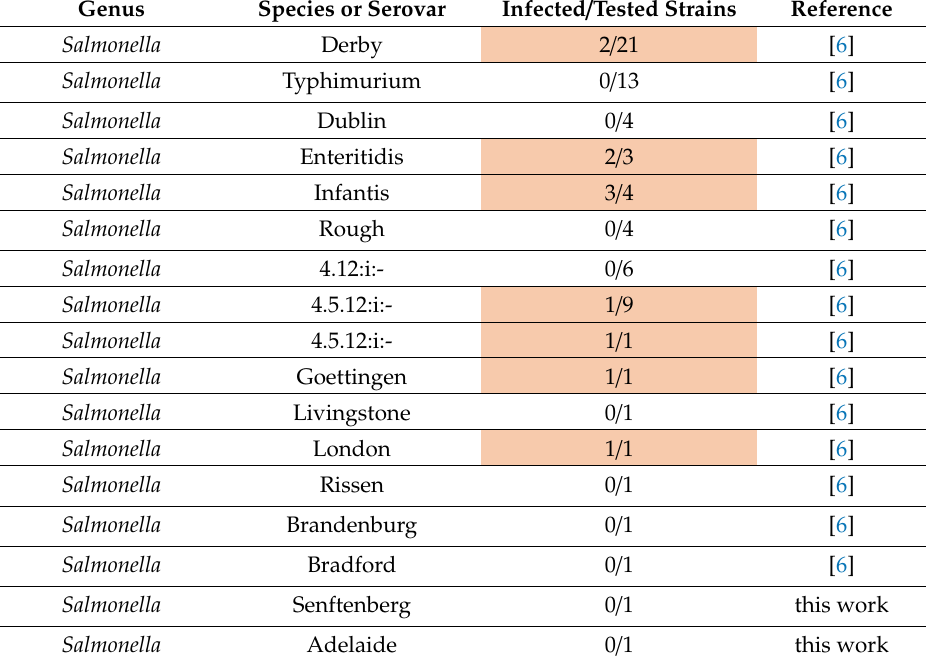
Table 1. Summary of the host range of phage S144, with genus, species or serovar and number of infected over the tested strains for each bacterial taxon (positive infections in orange). The full host range is reported in the Table A1 with the corresponding e ffi ciency of plating (EOP) for each strain. Genus Species or